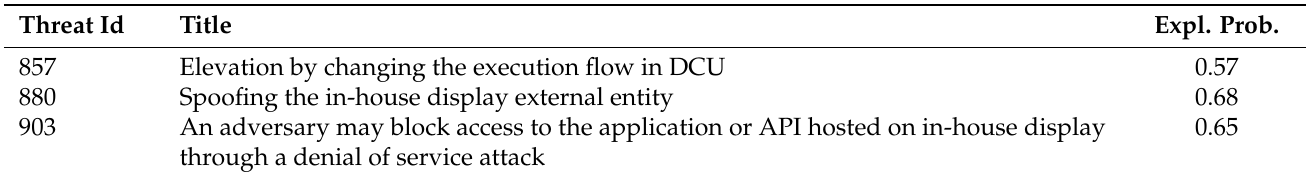
Table 4. UC2 Exploitation probabilities.